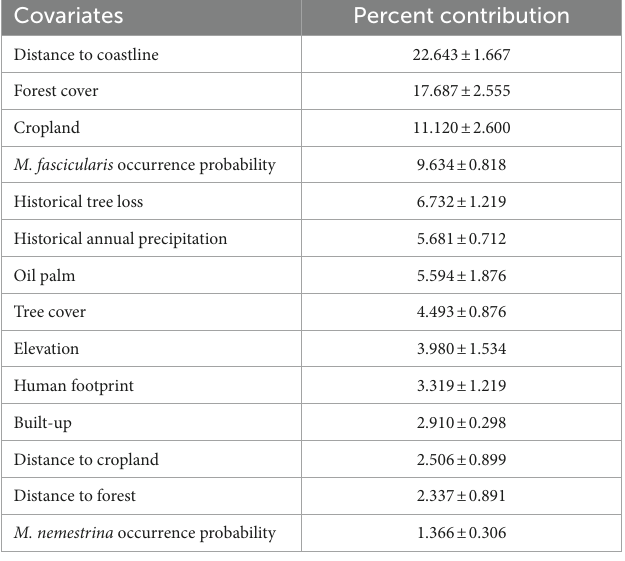
TABLE 1 Relative importance of each covariate toward modeling of human knowlesi malaria risk based on MaxEnt model percent contribution. Covariates